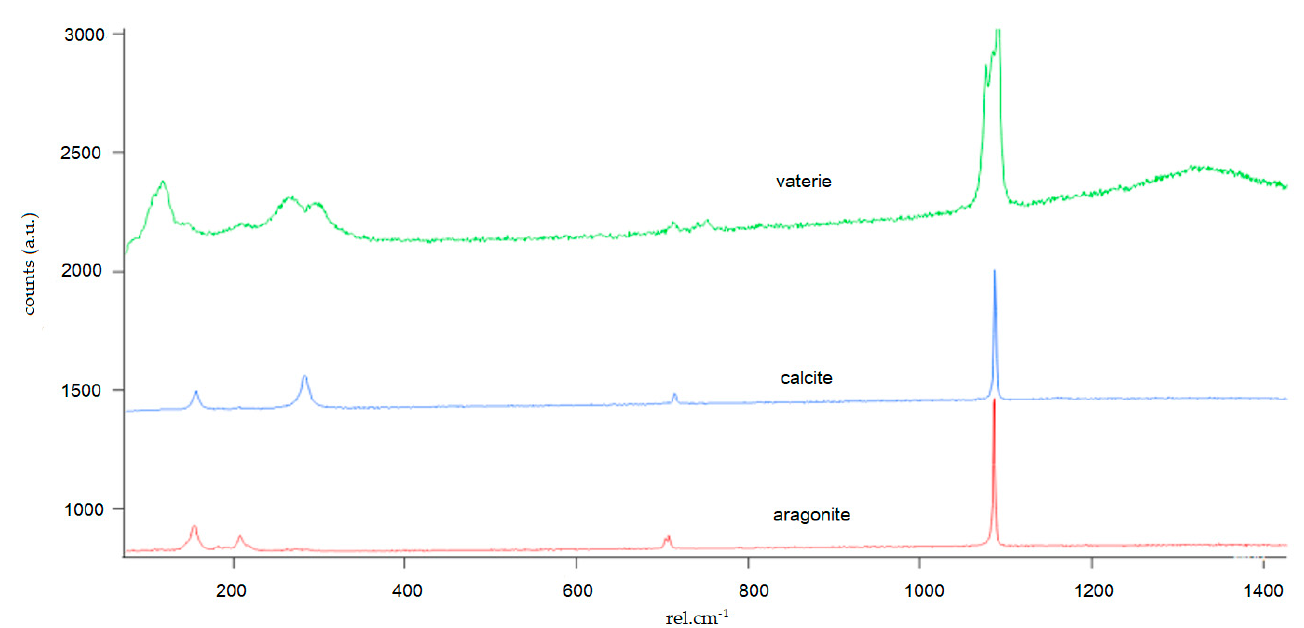
Figure A1. CaCO 3 polymorphs (aragonite, calcite, and vaterite) were identified via Raman spectroscopy, which were first morphologically identified by SEM on the incubated crystals. These Raman spectra were used to qualitatively identify the crystal structures found on the seeding crystals after incubation.